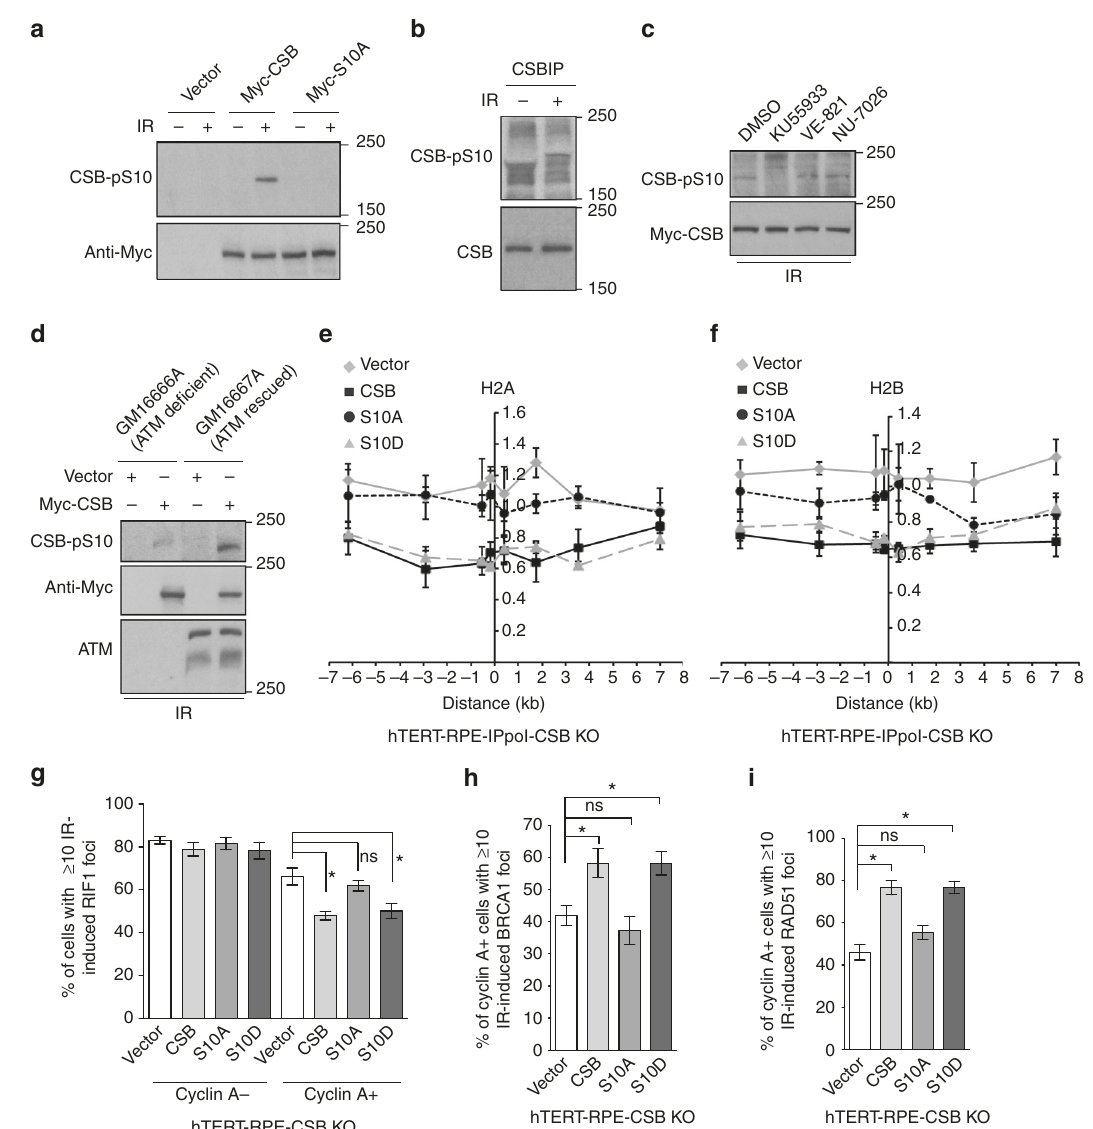
Fig. 7 ATM controls the chromatin remodeling activity of CSB through S10 phosphorylation. a Western analysis of U2OS CSB KO cells stably expressing various alleles as indicated. Cells were either treated with or without 10 Gy IR. b Western analysis of anti-CSB immunoprecipitates from HCT116 cells treated with or without 10 Gy IR. c Western analysis. Myc-CSB-expressing U2OS CSB KO cells were treated with DMSO, ATM inhibitor KU55933, ATR inhibitor VE-821 or DNA-PKcs inhibitor NU-7026 for 1 h prior to 10 Gy IR. d Western analysis of ATM-de fi cient GM16666A and ATM-complemented GM16667A cells. Cells were transfected with the vector alone or Myc-CSB, followed by treatment with 10 Gy IR 48 h post transfection. e Relative occupancy of histone H2A in ddI-PpoI-expressing hTERT-RPE CSB KO cells complemented with various alleles as indicated. Both x - and y -axes are as described in Fig. 5a. SEM from three independent experiments are indicated. f Relative occupancy of histone H2B in ddI-PpoI-expressing hTERT-RPE CSB KO cells complemented with various alleles as indicated. Both x - and y -axes are as described in Fig. 5a. SEM from three independent experiments are indicated. g Quanti fi cation of the percentage of cyclin A- and cyclin A+ cells with 10 or more IR-induced RIF1 foci. hTERT-RPE CSB KO cells stably expressing various alleles as indicated were treated with 2 Gy IR and fi xed 1 h post IR. A total of 500 – 550 cells were scored for each independent experiment in a blind manner. SDs from three independent experiments are indicated. * P < 0.05. ns: P > 0.05 (Student t test). h Quanti fi cation of the percentage of cyclin A+ cells with ≥ 10 IR-induced BRCA1 foci. Scoring was done as in 7 g. SDs from three independent experiments are indicated. * P < 0.05. ns: P > 0.05 (Student t test). i Quanti fi cation of the percentage of cyclin A+ cells with 10 or more IR-induced RAD51 foci. Cells were treated with 2 Gy IR and fi xed 4 h post IR. Scoring was done as in 7 g. SDs from three independent experiments are indicated. * P < 0.05. ns: P > 0.05 (Student t